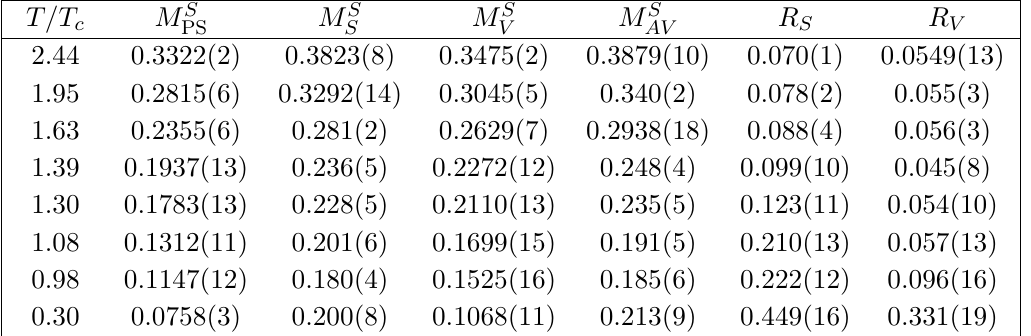
Table 5 . Simulation results for the N t (cid:2) 16 3 lattice. To compensate the anisotropy of the Euclidean lattice, meson screening masses M S are obtained from the measured masses divided by (cid:24) = 6 : 3. All calculations use (cid:24) 0 (cid:3) = 4 : 84, (cid:24) 0 (cid:3) = 4 : 72, m (cid:3) = (cid:0) 0 : 2148 and (cid:12) = 2 : 0. g 0 f